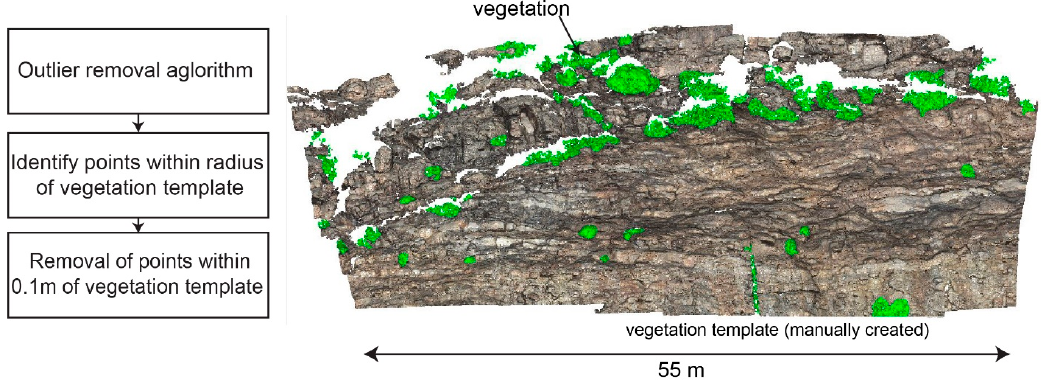
Figure 7. Vegetation removal algorithm consisting of outlier removal algorithm and vegetation removal using a vegetation template.